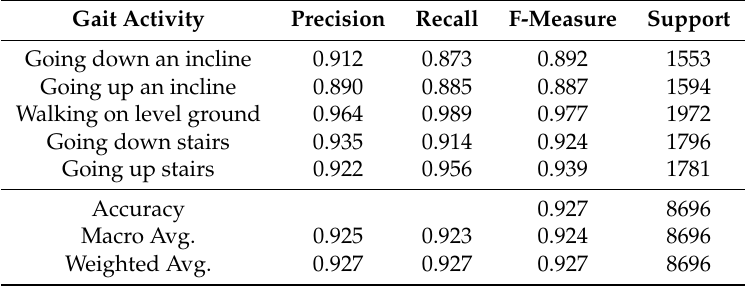
Table 9. Classification report of the CNN model trained with the augmented